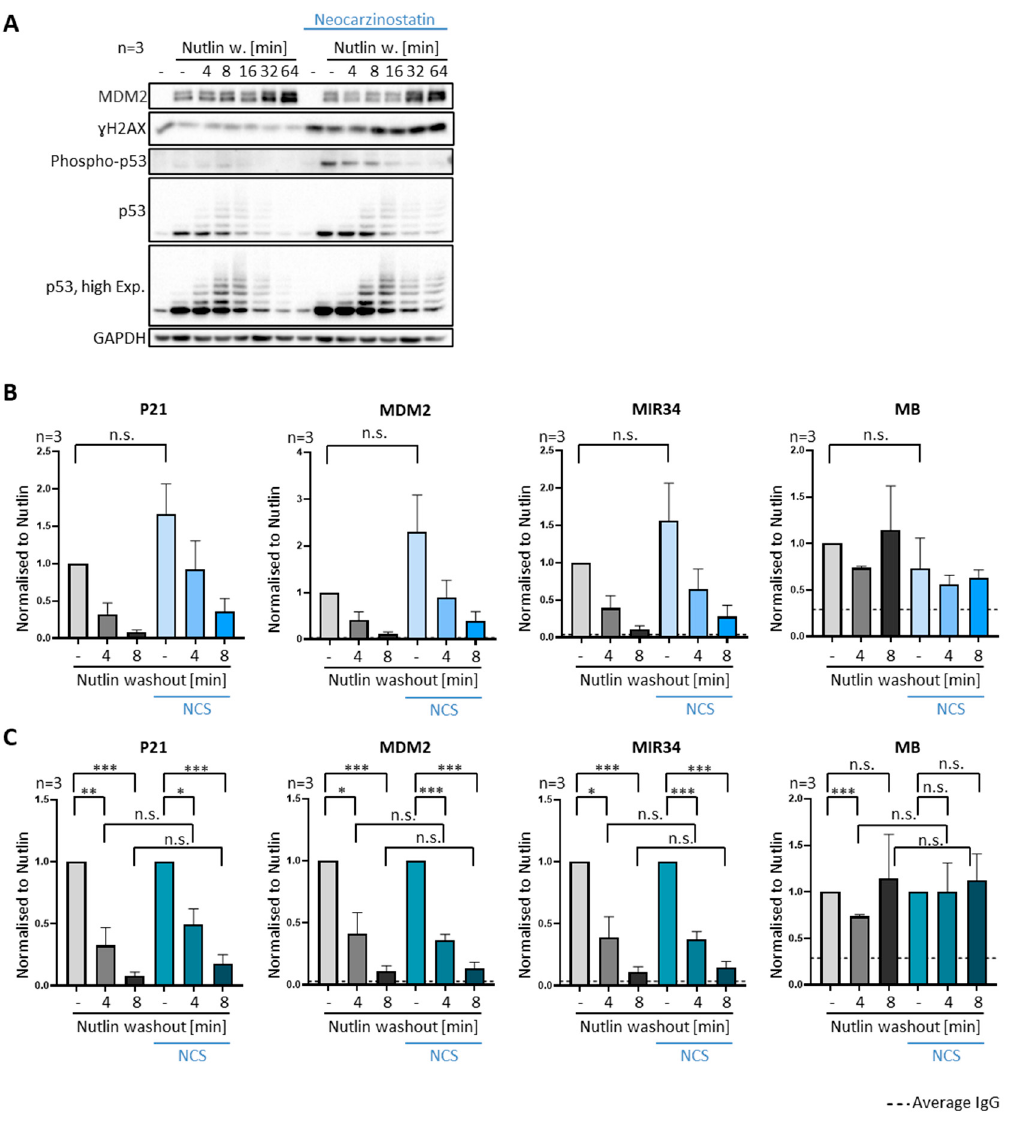
Figure 5. Removal of p53 regardless of DNA damage signaling. ( A – C ) SJSA cells were treated with 250 ng/mL of neocarzinostatin (NCS), a drug that induces double-strand breaks (DSBs) in cellular DNA. Treatment was started 2 h prior to Nutlin washout and was continued after Nutlin was removed. ( A ) Immunoblot analysis revealed the expected increase in the DNA damage marker γ H2AX and enhanced phosphorylated p53 at Serin 20. ( B ) The association of p53 with chromatin in SJSA cells was investigated by ChIP. P53 dissociated from its cognate promoters upon Nutlin washout regardless of NCS treatment. ( C ) Data as in ( B ) but normalized as described in Figure 3E. *** p < 0.001; ** p < 0.01; * p < 0.05; n.s., non-significant. “-“, no Nutlin washout. In agreement, we did not observe p53 ubiquitination after Nutlin washout and pro- longed proteasome inhibition even though MDM2 was reactivated, conceivably because ubiquitin monomers are eliminated from the cells under those conditions. Strikingly, this treatment also severely compromised or even abolished the removal of p53 from the target gene promoters upon Nutlin washout (Figures 6B,C and S3B,C). This is in stark contrast